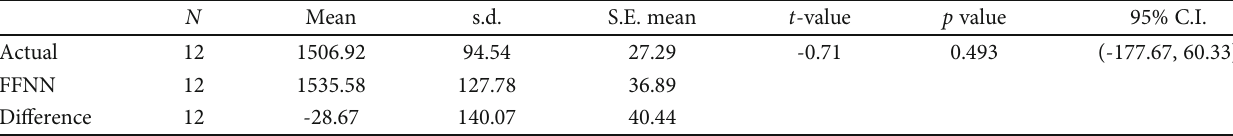
Table 6: Paired sample t -test results: actual versus FFNN forecast of 2018 demand.